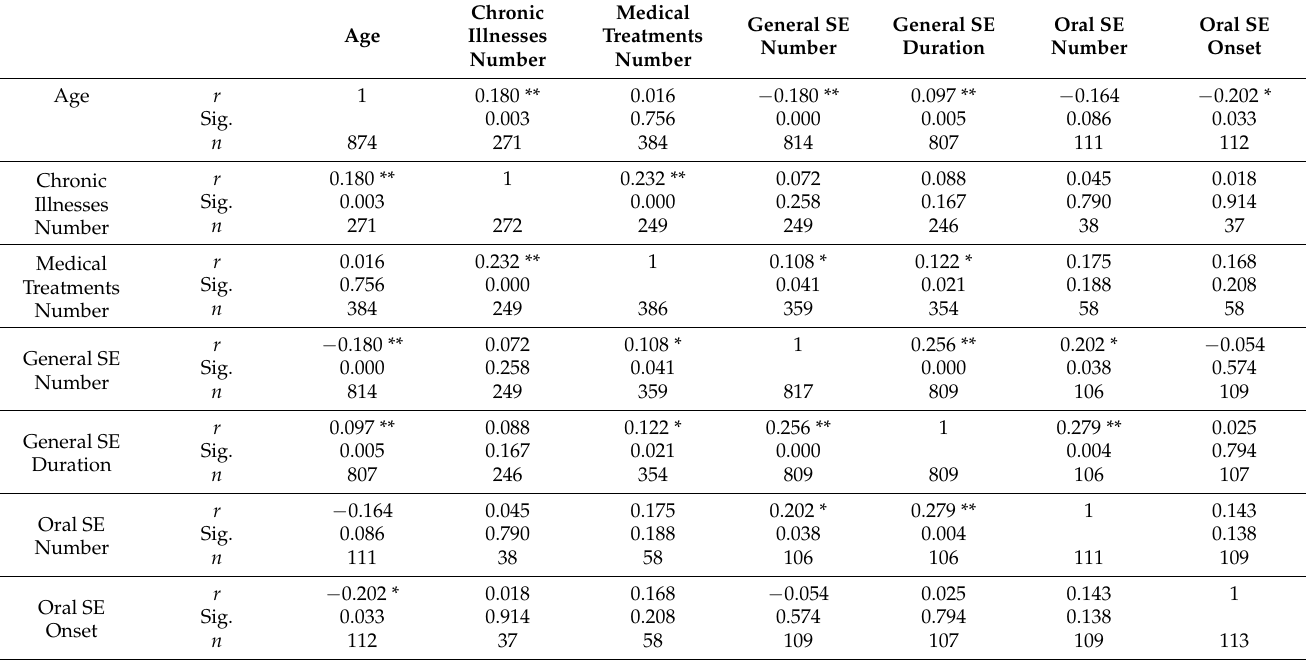
Table 9. Correlation between medical anamneses and side effects of Pfizer–BioNTech COVID-19 vaccine among healthcare workers in the Czech Republic, January–February